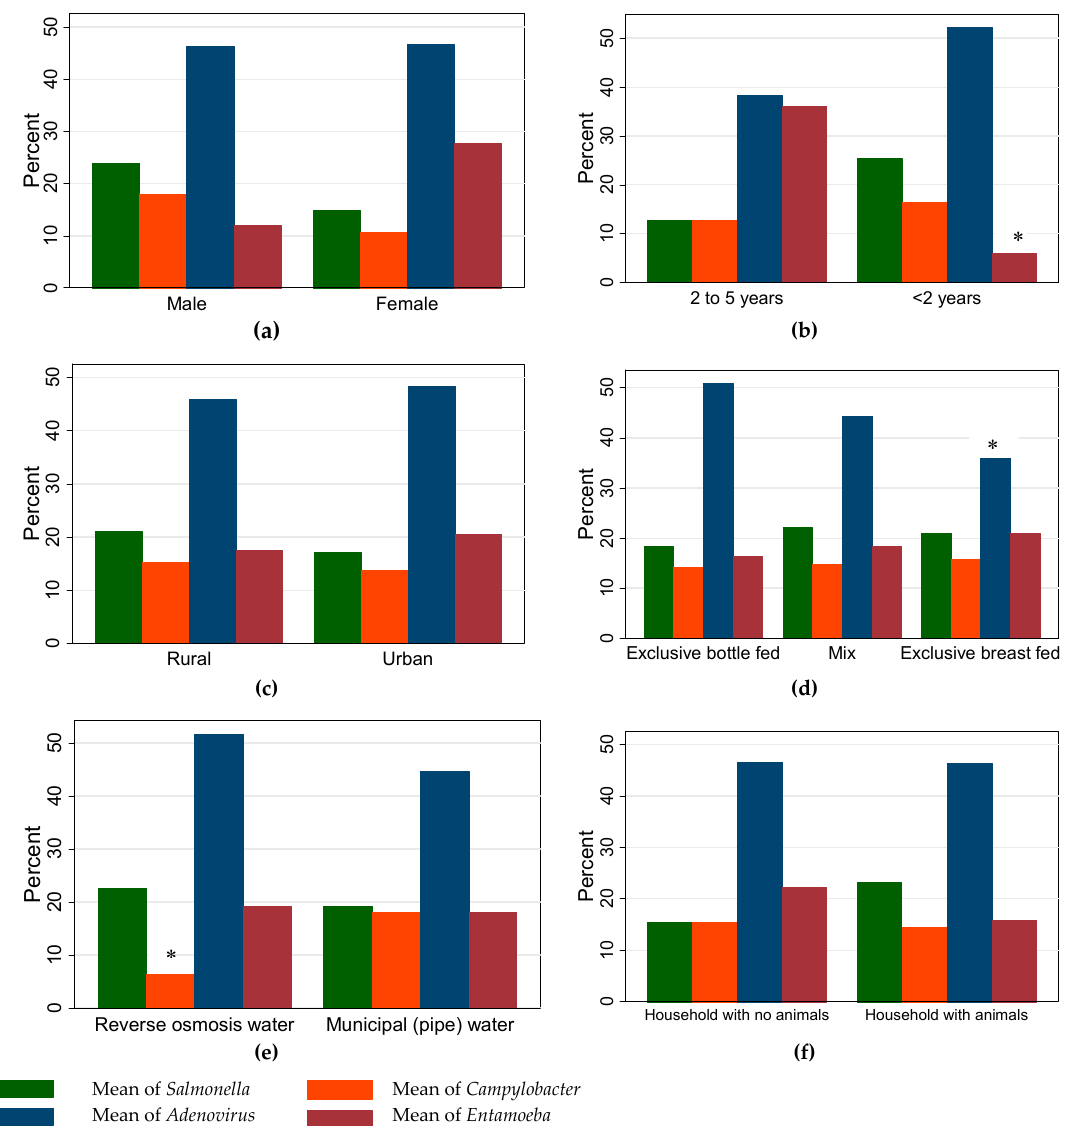
Figure 1. Distribution (percentage of cases) of demographic characteristics (sex ( a ), age ( b ) and residence ( c )), breastfeeding pattern in the first six months of age ( d ), and household features (water source ( e ) and domestic animals (f)) in relation to frequently ( > 10%) detected enteropathogens in diarrheal cases ( n = 155) among children < 5 years old. The symbol (*) denote bars of categories with statistical differences.